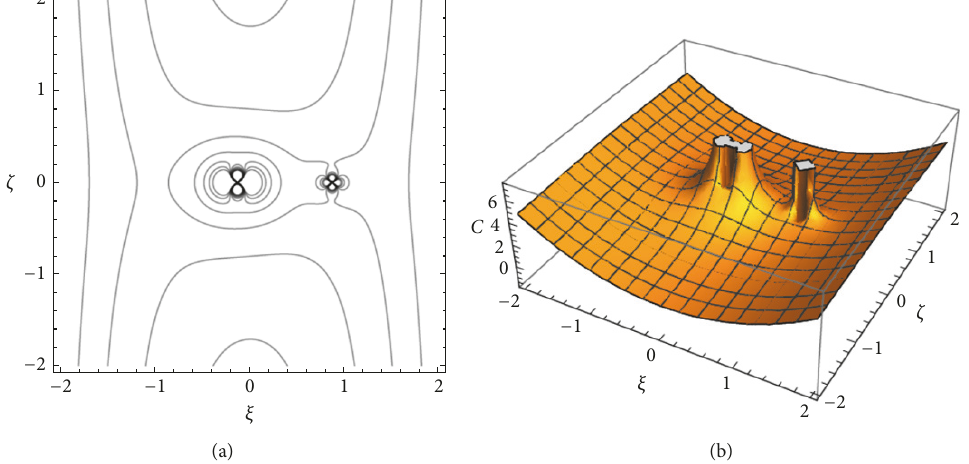
Figure 7: Zero-velocity curves in the ( 𝜉 − 𝜁 ) plane of DP-Leonis for 𝐴 = 0.02, 𝑒 = 0.2,𝑎 = 0.95, 𝜎 1 = 0.01 and 𝜎 2 = 0.005 .